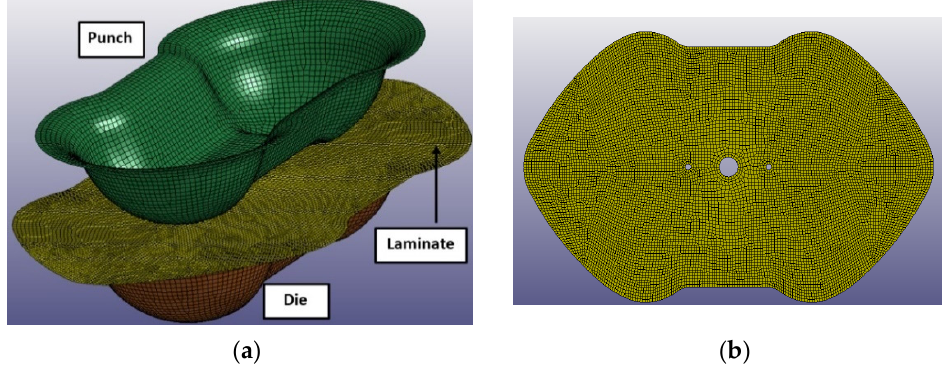
Figure 15. Double Dome thermoforming FEA model ( a ), Double Dome laminate mesh ( b ).